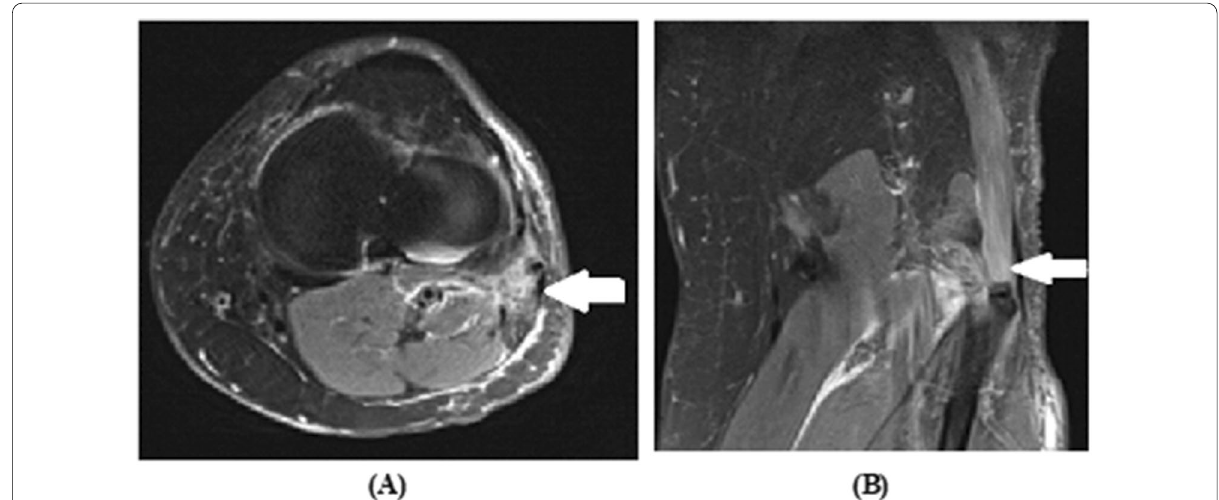
Fig. 8 A 56‑year‑old female patient suffering from instability and pain of the left knee following a recent twisting injury. Axial and sagittal PDFS images ( A , B ) showing hyperintense signal within the biceps femoris muscle and tendon denoting grade I–II injury